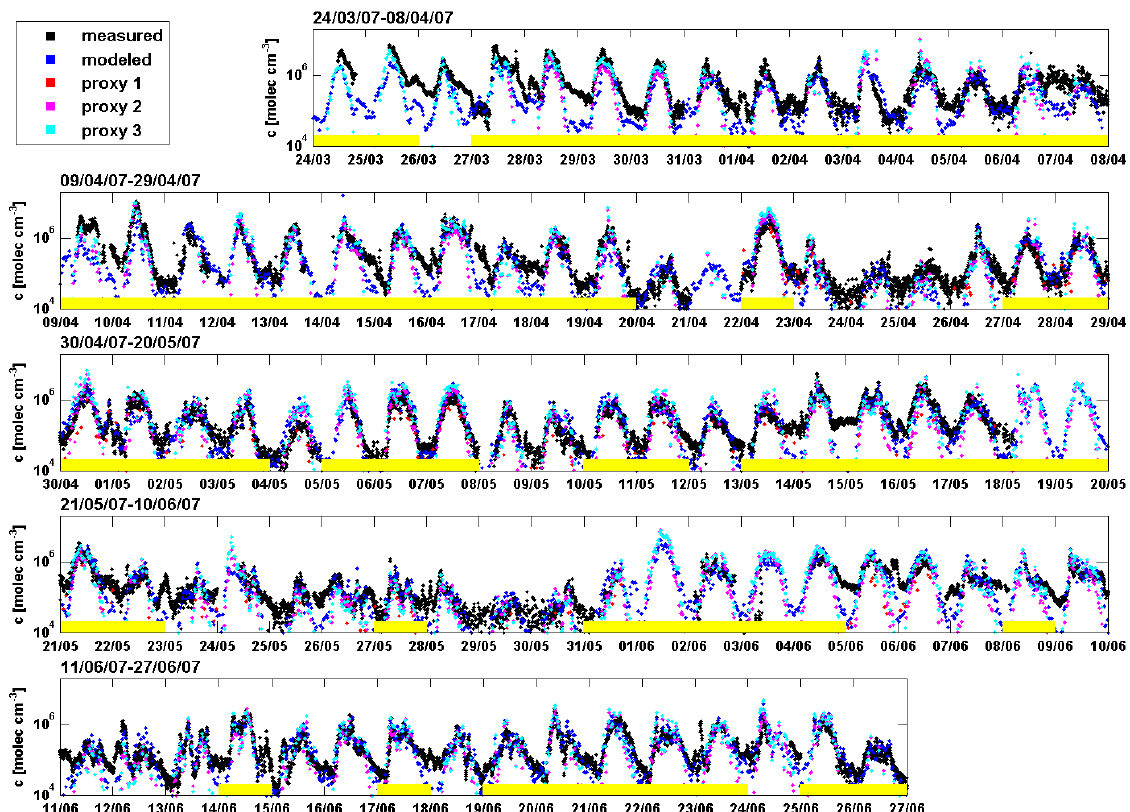
Fig. 1. Timeseries of 30-min averaged measured (black), modeled (blue) and proxy-estimated concentrations (red, magenta and cyan) of sulfuric acid from 24 March to 27 June 2007 in Hyyti¨al¨a. Days with new particle formation are indicated with yellow bar at the bottom of the graph.